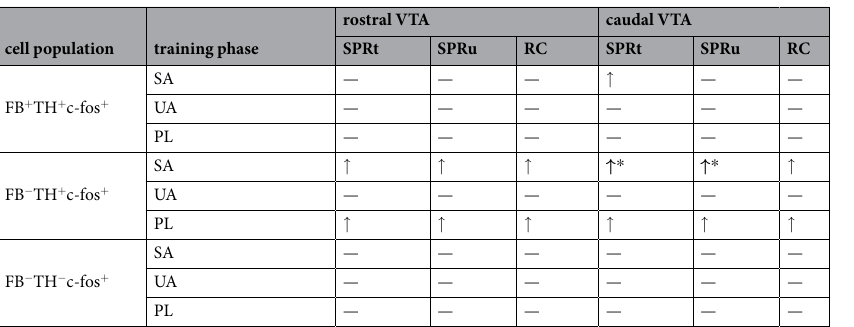
VTA-M1 projection during motor skill acquisition. VTA efferents, including those to M1, are highly target spe- cific and have few collaterals to other brain areas 9,10 . As such, forelimb and hindlimb representations in M1 are innervated by separate populations of VTA neurons 11 . The VTA-M1 projection neurons that were not activated in successful learners may thus be concerned with body parts other than the forelimb. In contrast to successful learners, rats that failed to successfully acquire the skilled reaching task did not show increased activation of dopaminergic VTA neurons compared to untrained, non-rewarded controls. However, the distribution of TH + cfos + neurons in unsuccessful learners resembles that of successful learners, suggesting that some dopaminergic VTA neurons may be involved in task execution, irrespective of reaching success. This is in line with a role for VTA dopamine release in sustaining and organizing ongoing task-related behaviors 25–27 .